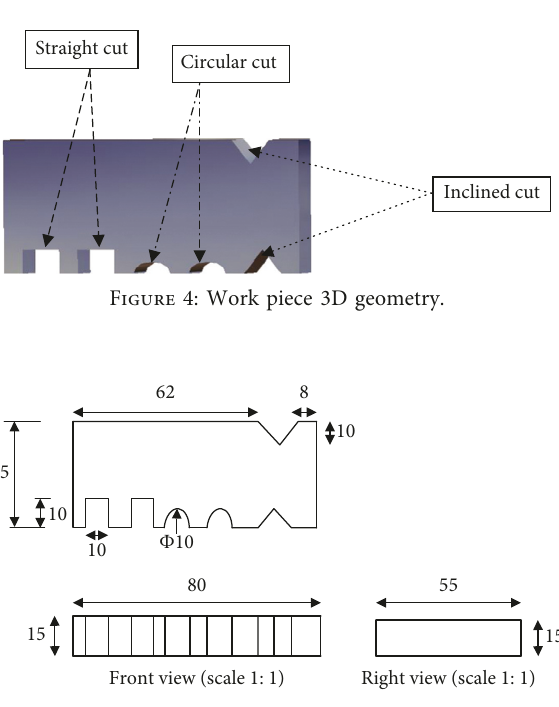
Figure 5: Work piece 2D